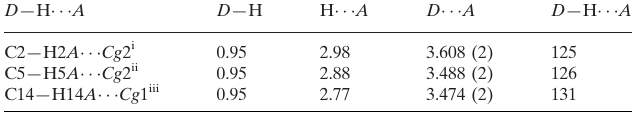
Hydrogen-bond geometry (A˚ , (cid:2)